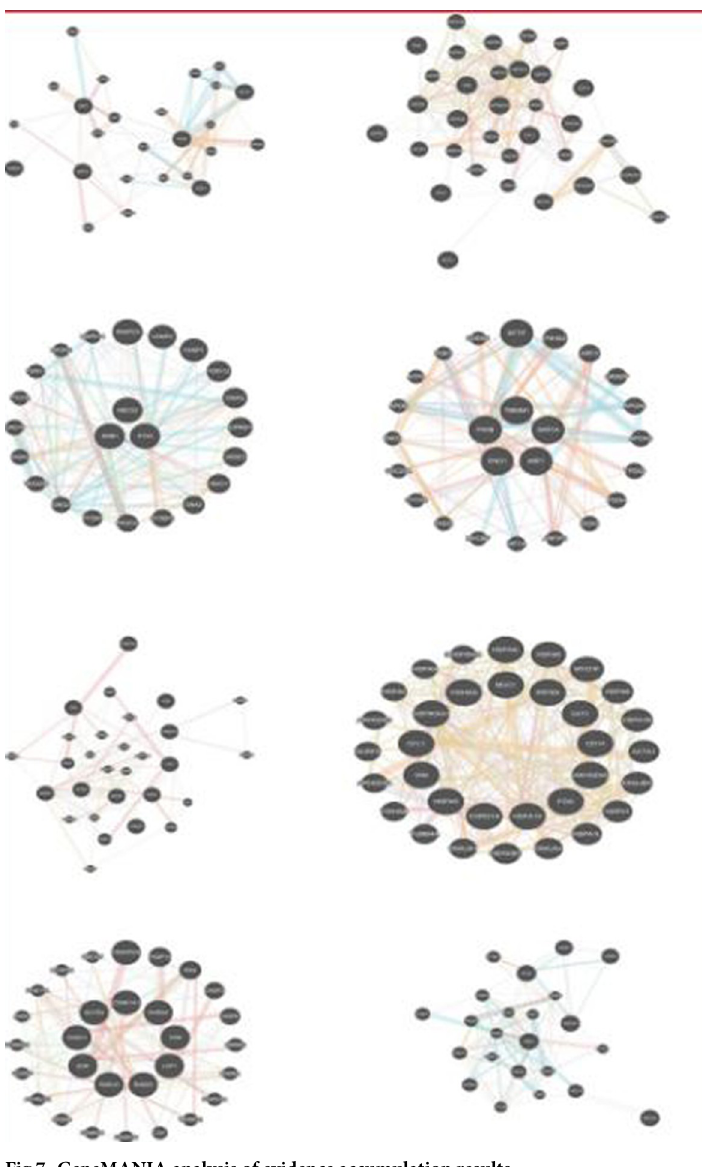
Fig 7. GeneMANIA analysis of evidence accumulation